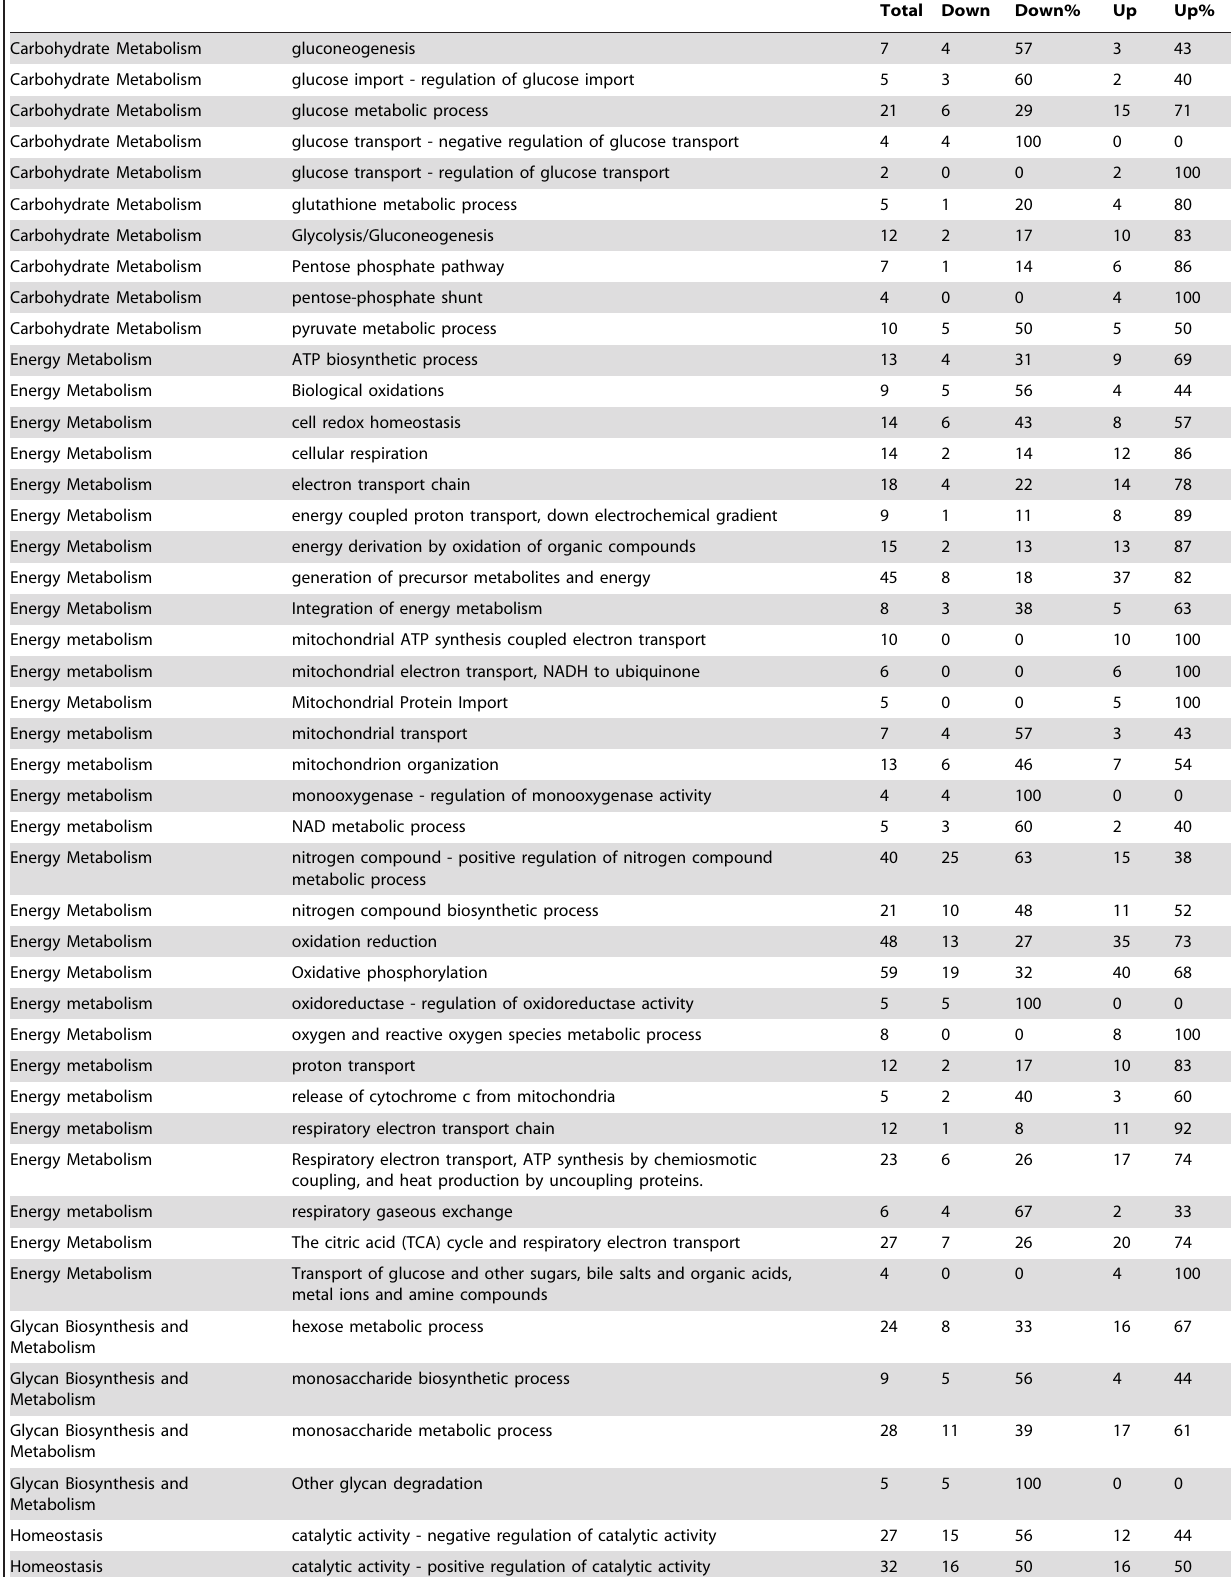
Total Down Down%